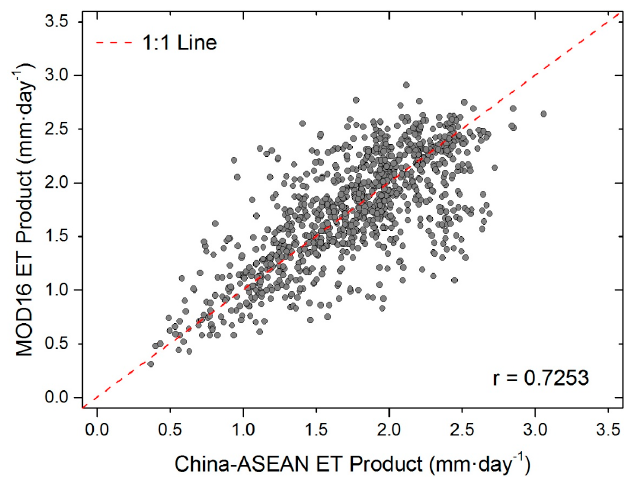
Figure 1. Scatter plot of the China–ASEAN ET product against the MOD16 ET product on the 281st day of 2013 for a rectangular site near the study area.